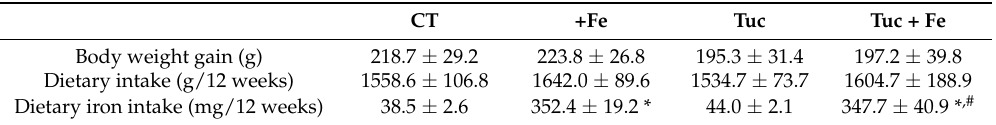
Table 1. Effect of iron and/or tucum-do-cerrado intake in the body weight gain, dietary intake and dietary iron intake of adult rats treated for 12 weeks.